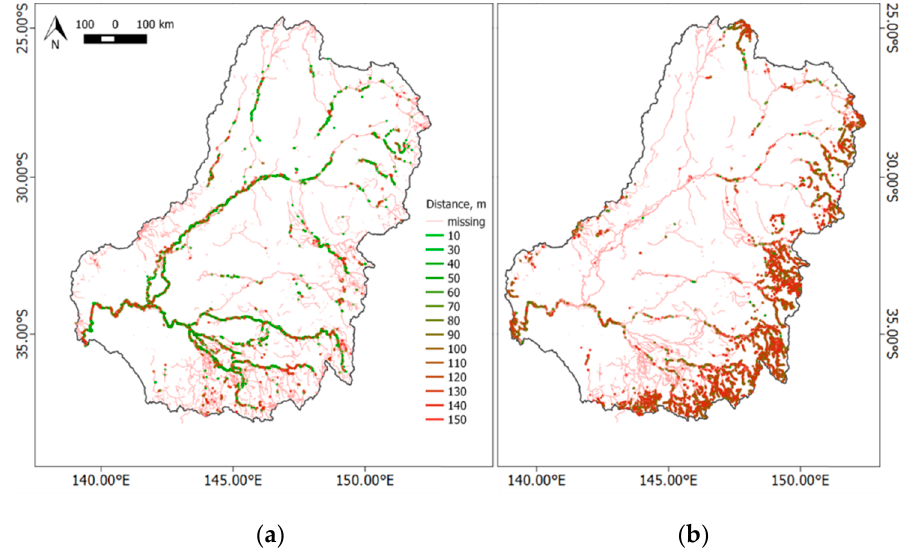
Figure 16. Positional differences between linear water features extracted from OSM, water mask centerline extracted from Landsat ( a ); and drainage network extracted from SRTM ( b ).